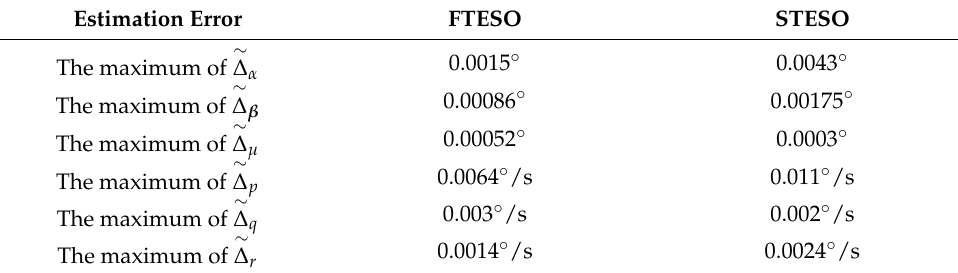
Table 2. Comparison of the estimate accuracy of FTESO and